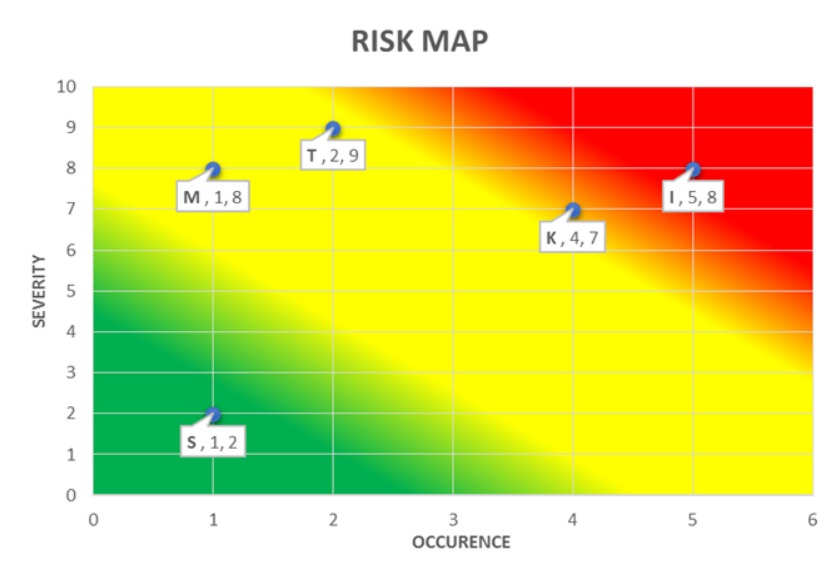
Figure 4. Risk Map of Risk Priority Number (RPN) for